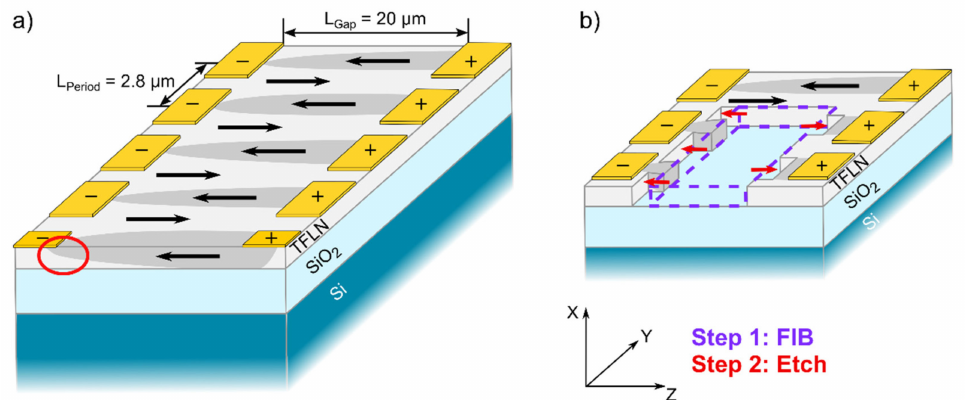
Figure 1. ( a ) Sketch of the periodically-poled x-cut thin film lithium niobate (TFLN) sample, consisting of a 300 nm lithium niobate (LN) thin film on a silicon substrate with silicon oxide (1800 nm). TFLN polarization is inverted by surface Au electrodes (period: 2.8 µ m, gap distance: 20 µ m). The inverted domains (dark grey) might not reach across the full depth of the LN thin film, as indicated in the foremost domain (red circle), since inversion along the z -axis proceeds faster than along x. ( b ) Selective etching scheme on x-cut TFLN. After exposure of the LN z-face by focused ion beam (FIB) (purple dashed box), subsequent etching with a higher etch rate on the negative polar face reveals the domain pattern, which is then ready to be visualized by standard imaging